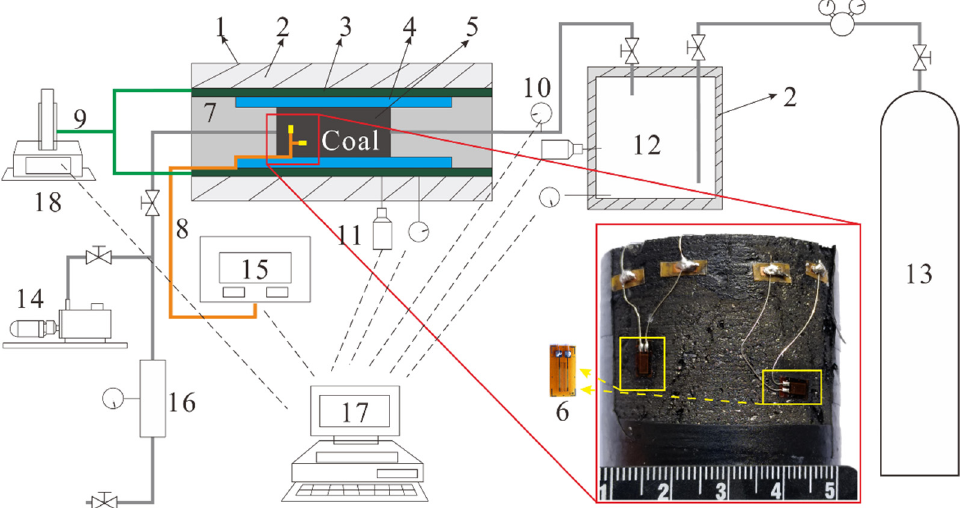
Figure 3. Schematic diagram of adjustable confining pressure adsorption–desorption process and stress/strain monitoring platform: 1, sample holder; 2, heating jacket; 3, hydraulic layer; 4, rubber sleeve; 5, cylindrical coal sample; 6, strain gauge; 7, plug; 8, wire; 9, water pipeline; 10, pressure sensor; 11, temperature sensor; 12, reference cell; 13, gas cylinder; 14, vacuum pump; 15, strain indicator; 16, gas collector; 17, computer; 18 confining pressure tracking pump.